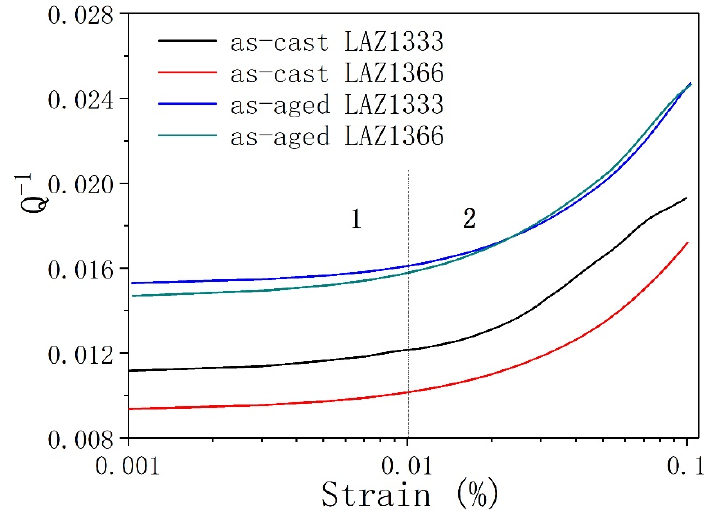
Figure 15. Dependence of the damping capacity of the LAZ13 xy ( x = 3, 6 wt%, y = 3, 6 wt%) alloys in different states as a function of strain amplitude tested.